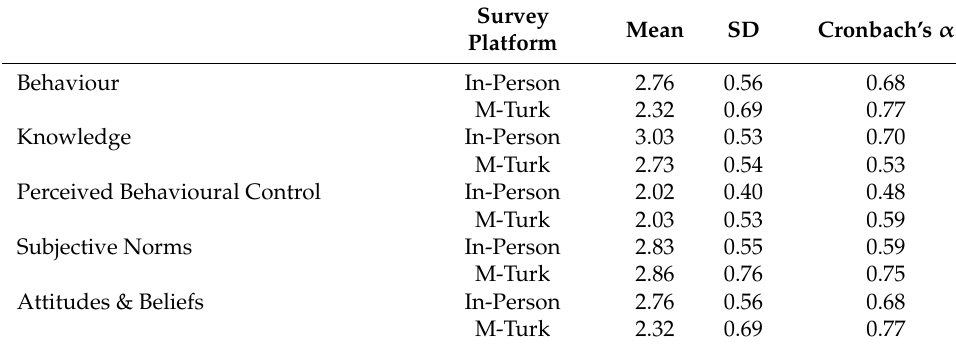
Table 5. Reliability and Descriptive Statistics for TPB